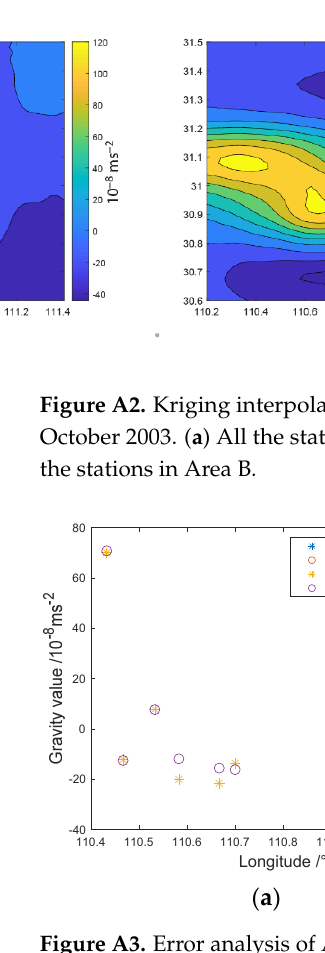
Figure A1. The difference results of the gravity observations from October 2002 to October 2003. ( a ) All stations, ( b ) remove the riverside Area A, and ( c ) remove the mountain Area B.